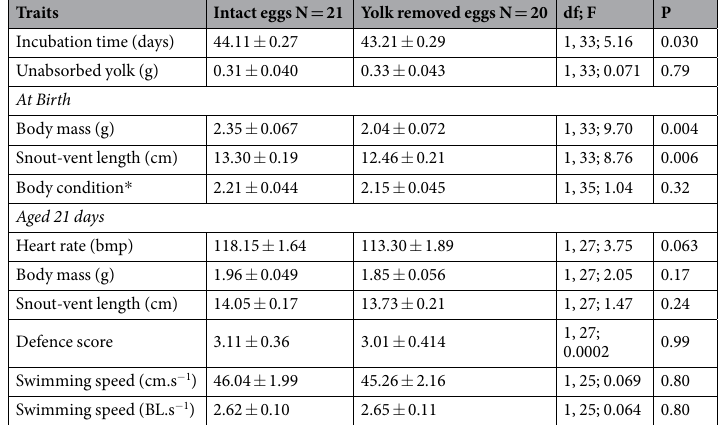
Table 2. Two-way Anovas with treatment and clutch of origin as factors and relevant traits were performed. All interaction effects were non–significant therefore only data for main effect treatment is shown. Mean ± SE are given. * Body mass relative to snout-vent